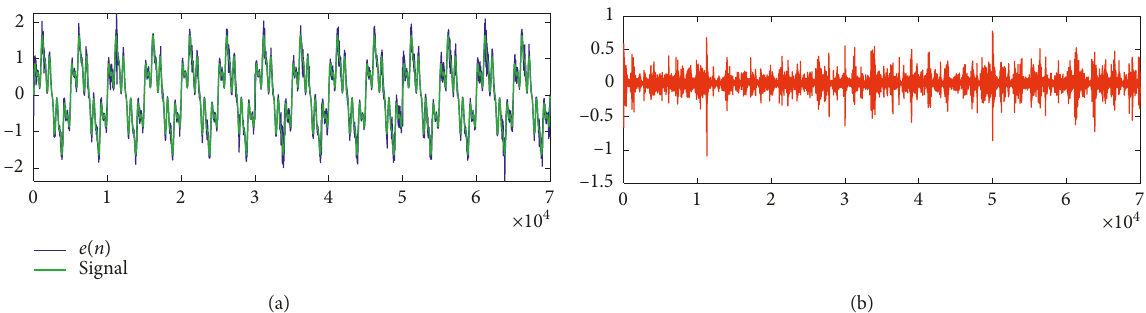
n . (b) Residual noise. ( )